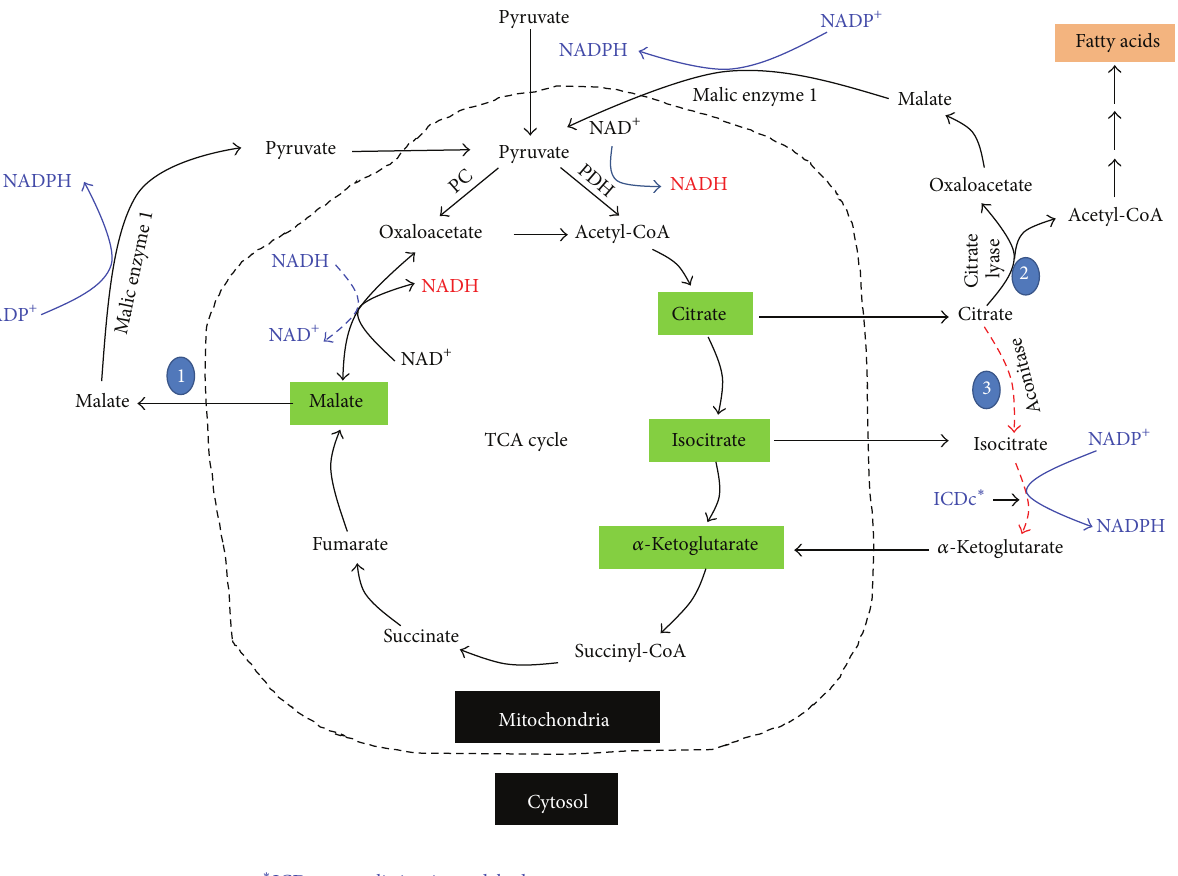
Figure 4: The pyruvate recycling pathways in 𝛽 cell mitochondria. The three pathways shown are pyruvate-malate pathway, the pyruvate- citrate pathway, and the pyruvate-isocitrate pathway. Each pathway converts reducing equivalents from NADH to NADPH that plays key roles in the second phase of insulin